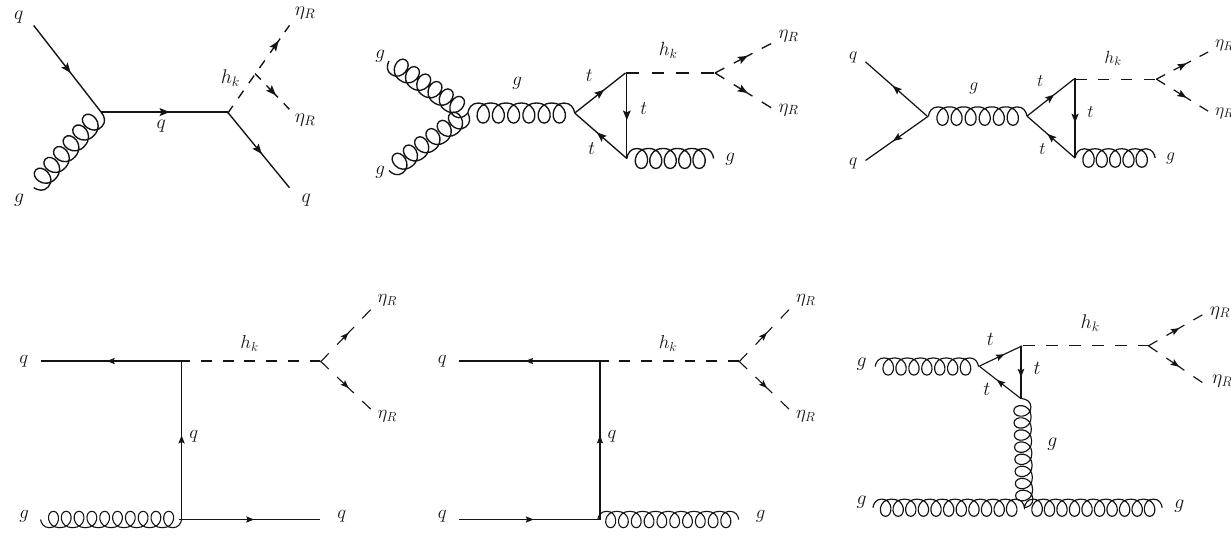
Fig. 7 Relevant Feynman diagrams for mono-jet production through η R η R + j at the LHC; here h k ≡ h 0 or H